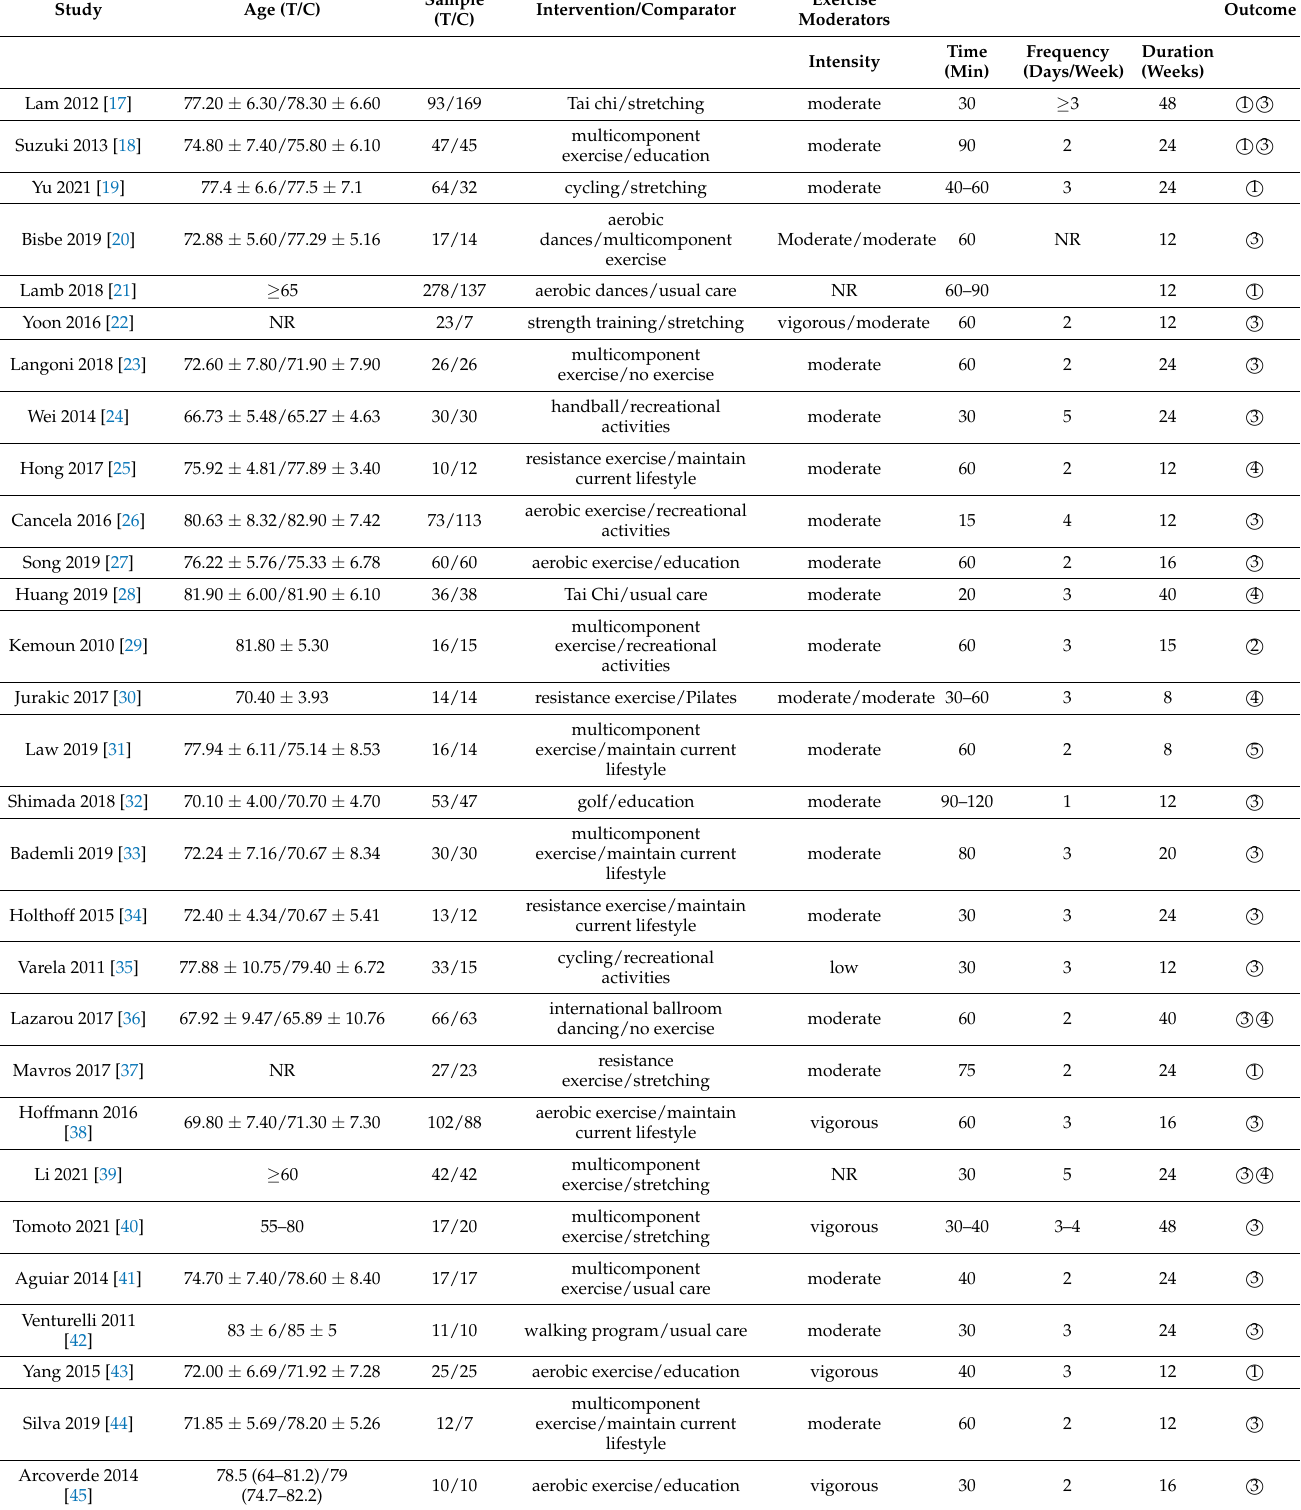
Table 2. Summary of studies included in the